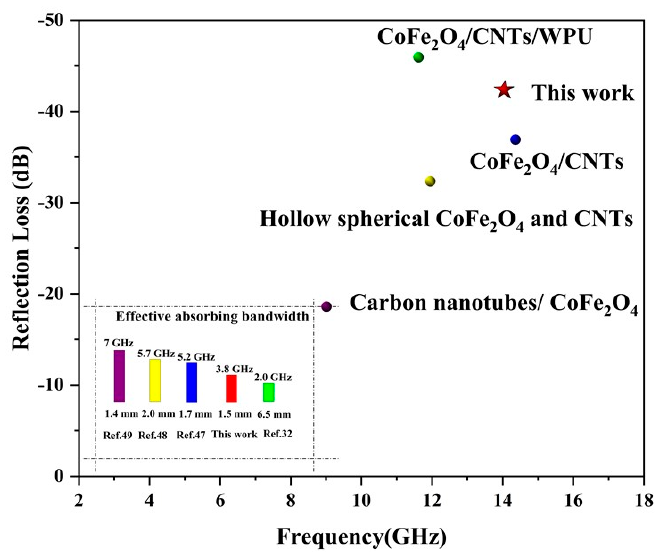
Figure 11. Comparison of the electromagnetic wave absorption capacity of this part of work with some composites of CoFe 2 O 4 /carbon [32,47–49].